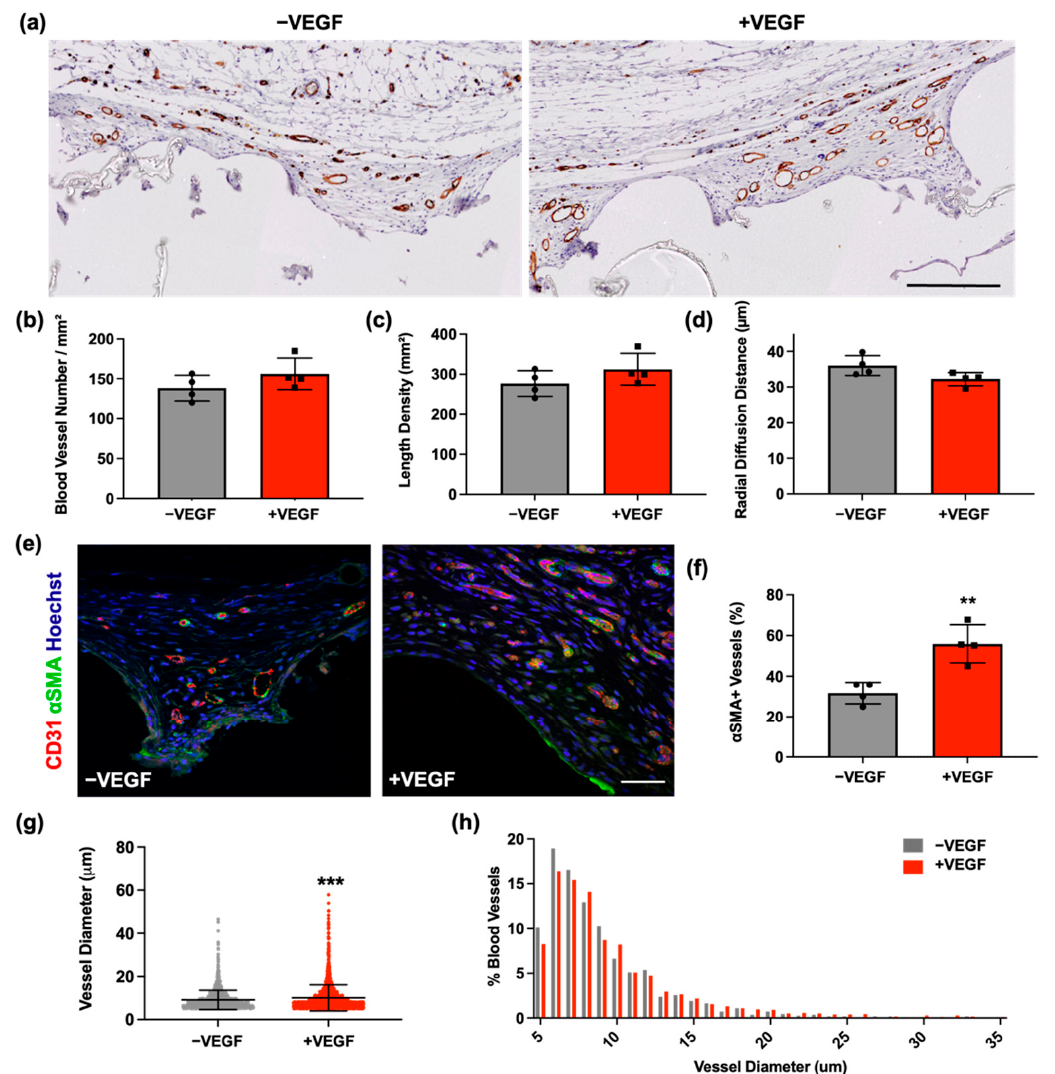
Figure 3. VEGF increases vessel maturity, stability, and vessel diameter. ( a ) Representative images of CD31 staining of vasculature surrounding − VEGF and +VEGF devices. Scale bar = 200 µ m. ( b ) Number of blood vessels per mm 2 . ( c ) Length density. ( d ) Radial diffusion distances. ( e ) Representative fluorescent images of α SMA (green) and CD31 (red) staining of fibrous capsules for − VEGF and +VEGF samples. Scale bar = 50 µ m. ( f ) Percentage of α SMA+ vessels for analysis of vessel stability and maturity. ( g ) Blood vessel diameters ( h ) Percentage frequency distribution of blood vessel diameters surrounding − VEGF and +VEGF devices. n = 4 per group, data are represented as means ± SD, ** p < 0.01, *** p <